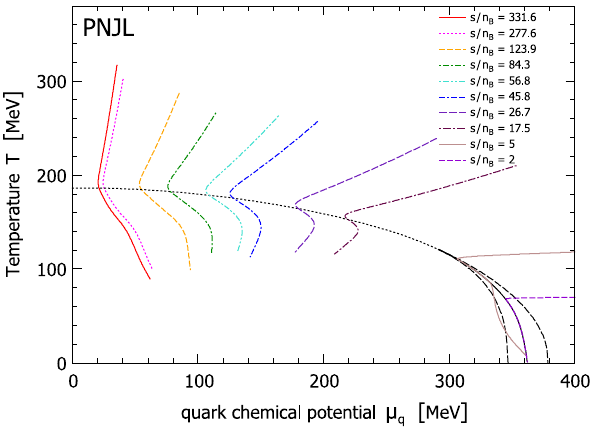
metastable phase is possible. We also show, in different colours, the isentropic trajectories referring to the s / n B values given in Table 4. Each curve starts at a temperature T 0 corresponding to the values of s 0 given in Table 4 and is plotted down to the corresponding kinetic freeze-out temperature T fo . We also plot two isentropic trajectories so far not covered by the BES and entering into the first-order